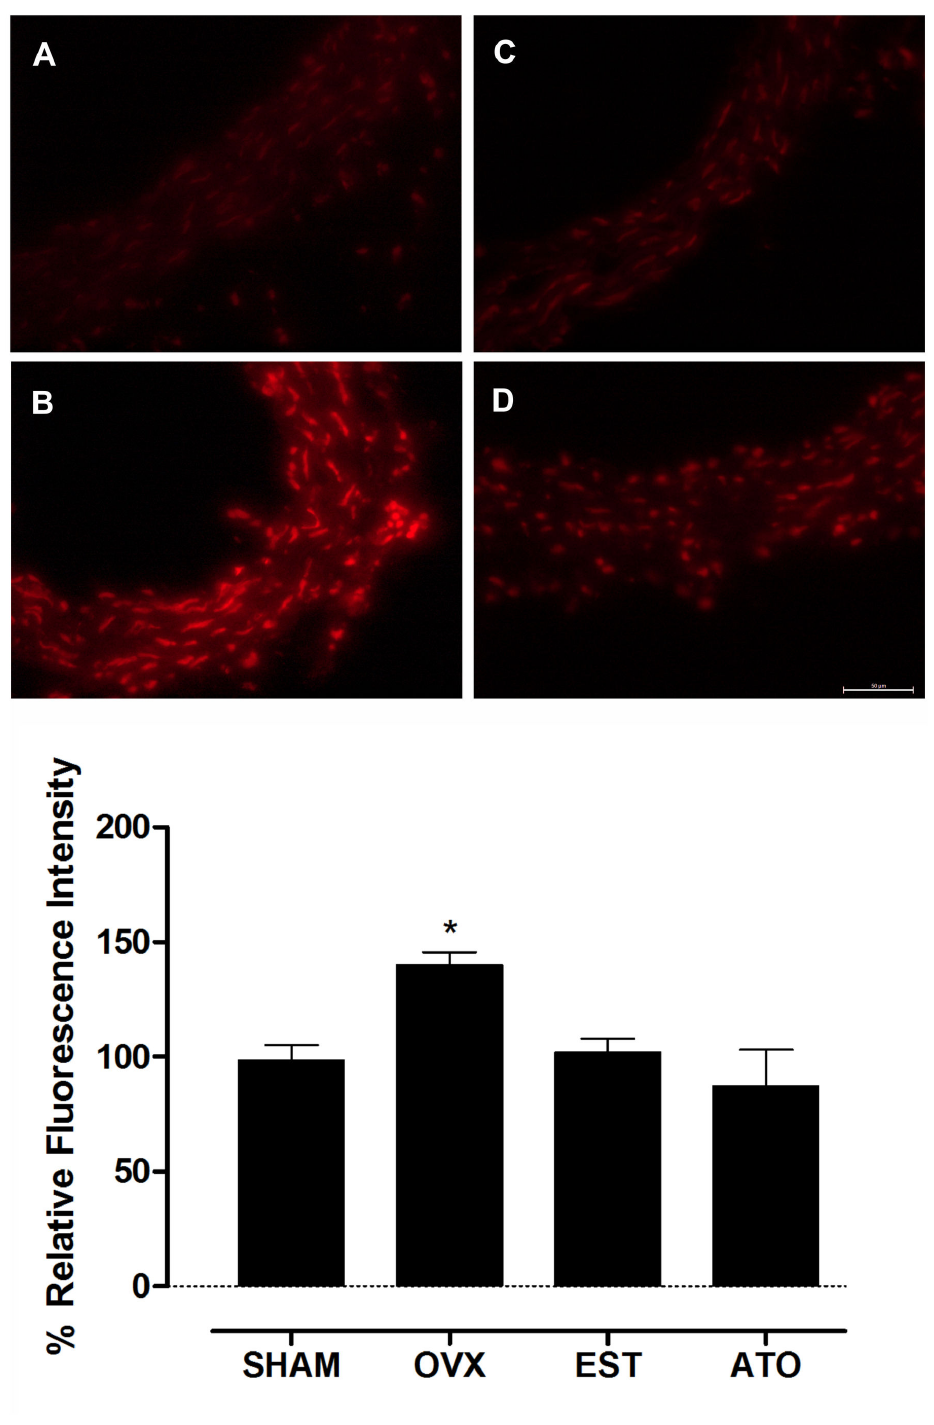
Figure 3. Atorvastatin treatment improves oxidative stress in the mesenteric arteries from ovariectomized rats. Representative DHE staining in mesenteric arteries from the control (SHAM) (A), ovariectomized (OVX) (B) and ovariectomized treated with 17β-estradiol (EST) (C) or atorvastatin (ATO) (D) groups (upper panel). The fluorescent intensity was quantified based on the red signal (magnification x40, lower panel). Each column represents the mean of 6 experiments ± S.E.M., and the results are expressed as the percentage of the SHAM group. *P<0.05 vs. the SHAM group by one-way ANOVA followed by Tukey’s test. doi: 10.1371/journal.pone.0080892.g003 PLOS ONE |